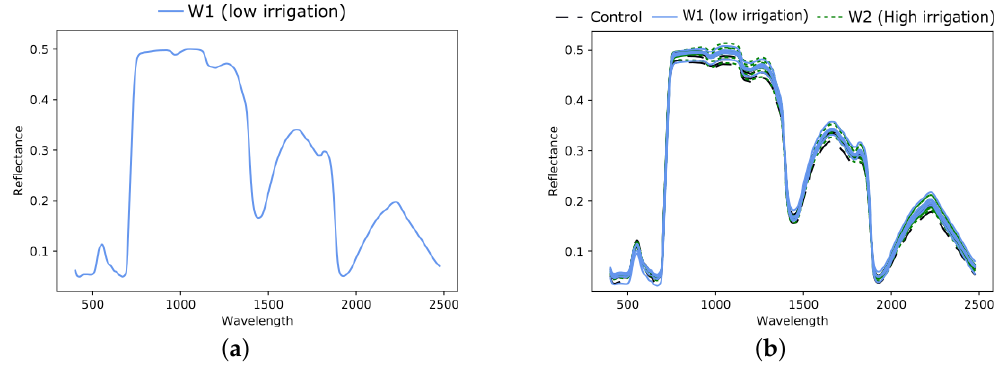
Figure 9. Leaves’ spectra acquired on 23 August 2019 in plot B (SWP mean value for this date: control = − 1.2 MPa, W1= − 0.80 MPa, W2 = − 0.65 MPa). ( a ) Example of one spectra of a row subplot for W1 irrigation; ( b ) all spectra for each row subplot of the three irrigation